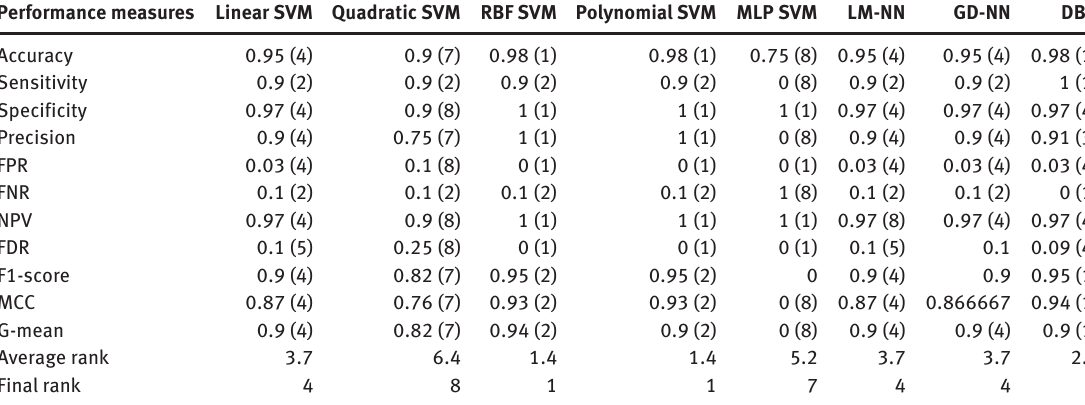
Table 3: Performance Analysis of Proposed and Conventional Fault Signal Recognition in Power Distribution System for Sag